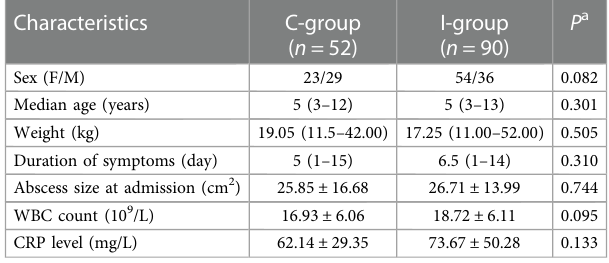
TABLE 1 Patient demographics and clinical characteristics of the control group and intervention group before treatment.